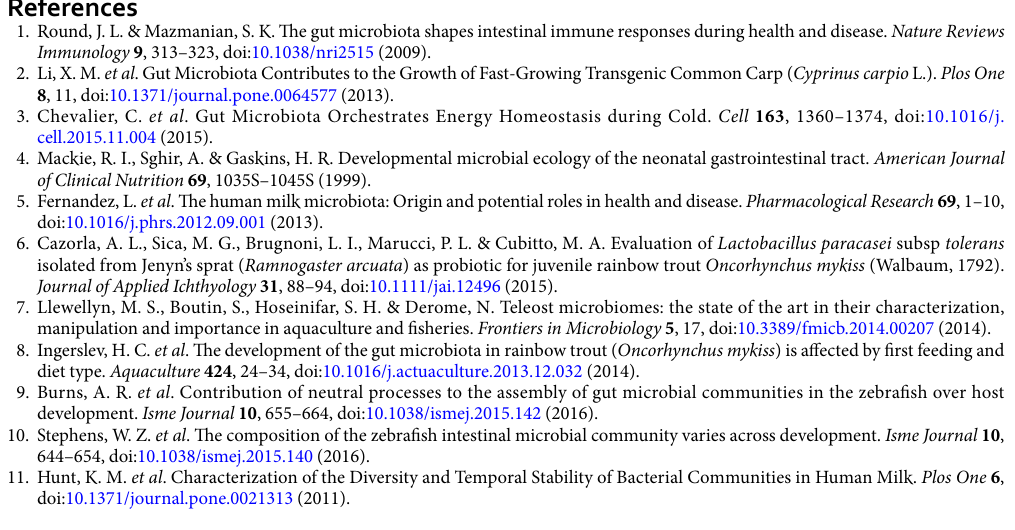
from all sequences using filter_fasta.py . The script pick_de_novo_otus.py was used for de novo operational taxo- nomic unit (OTU) picking. For all downstream taxonomic analyses, the OTU table produced by de novo OTU picking was used, as it does not exclude OTUs absent from online databases (as opposed to closed reference OTU picking). The GreenGenes online database gg_13_8_otus was used to annotate OTUs. OTUs with less than 50 reads or that only occurred in one sample were filtered out as a step to improve accuracy and diversity 53 . Samples with a low sequencing depth ( < 500 reads) were discarded. A rarefaction plot can be found in Supplementary material (Supplementary Figure 1). OTU tables were normalized with the abundance-based metagenomeSeq’s cumulative sum scaling (CSS) transformation 54 using the QIIME script normalize_table.py . The normalized OTU table was used for all downstream analysis. For all downstream analysis, the fry samples were separated into four developmental stages: before mucus feeding (0–3 DPH), during mucus feeding (4–20 DPH), early after mucus feeding (50–80 DPH), and later after mucus feeding (80–100 DPH). Shannon’s and Chao alpha diversity measures were obtained for each sample with mothur software ( summary.single command) and were plotted on R version 3.2.1 using package ggplot2 55 . The Yue & Clayton measure of dissimilarity, the Thetayc index 56 , was calculated using mothur ( dist.shared command). Permutational analyses of variance (PERMANOVA) were performed with the vegan package 57 from R to assess if microbial community composition differences were significant between clusters of samples. The defined clusters were: whole larvae microbiota from 0 to 3 DPH, whole larvae microbiota from 4–20 DPH, fry fecal microbiota from 50 to 80 DPH, fry fecal microbiota from 80 to 100 DPH, adult discus fecal microbiota, discus parent mucus microbiota when feeding fry, discus parent mucus microbiota when not feeding fry and water samples. For each analysis of variance, 10 000 permutations were applied. The recruitment of bacterial taxa from specific microbial reservoirs, by the fry throughout their development, was assessed using a homemade “recruitment index”. The recruitment index was calculated for each of the four potential microbial reservoirs (environmental water, parent’s skin mucus, parent’s feces, or adult diet). To calcu- late this recruitment index, we first identified the OTUs that were shared between each microbial reservoir and the fry. After, we calculated the average relative abundance of the total microbial community of each targeted microbial niche, that was represented by the shared OTUs. Finally, we obtained the recruitment index by dividing the relative abundance of the total microbial community represented by shared OTUs in the microbial reservoir by the relative abundance of the total microbial community represented by shared OTUs in the fry gut. When, for a specific microbial reservoir, the recruitment index was > 1, it indicated that a high proportion of rare OTUs from this reservoir were positively recruited by the fry gut, where they proliferated and became more ubiquitous. P-values were assessed for the recruitment index by T-tests for two-tailed distribution with unequal variance. For the three microbial reservoirs that had a significant recruitment index, a network of relative co-abundance between microbial taxa was constructed with Cytoscape version 3.2.1 58 . Only the 50 most abundant OTUs (defined at the lowest taxonomic level possible) were used to construct the network. Spearman’s correlations were calculated between each microbial taxa relative abundance pair using R. A p-value, corrected with Bonferroni, was determined for each Spearman’s correlation value. Significant correlation values used for the network con- struction had a Spearman’s correlation ≥ 0.9 and a Bonferroni corrected p-value ≤ 0.0001. The nodes of the network represent a microbial taxa and the edges (i.e. connections between nodes) are attributed to significant correlation between nodes. Multifactorial Analysis (MFA) were performed (Figs 2g and 4a) with R using the package FactormineR 59 . The MFAs enable multidimensional visualization of the data. They are used to simultaneously study patterns observed in continuous (OTU normalized abundance) and categorical (e.g. parenting versus non-parenting fish) variables. Confidence ellipses were drawn around clusters of data points with default settings of the plotellipses function. Clusters with non-overlapping ellipses are considered significantly different (default confidence level of 0.95). Variance equality between clusters of samples (e.g. mucus of parenting fish versus non-breeding fish) was assessed with F-tests on StatPlus